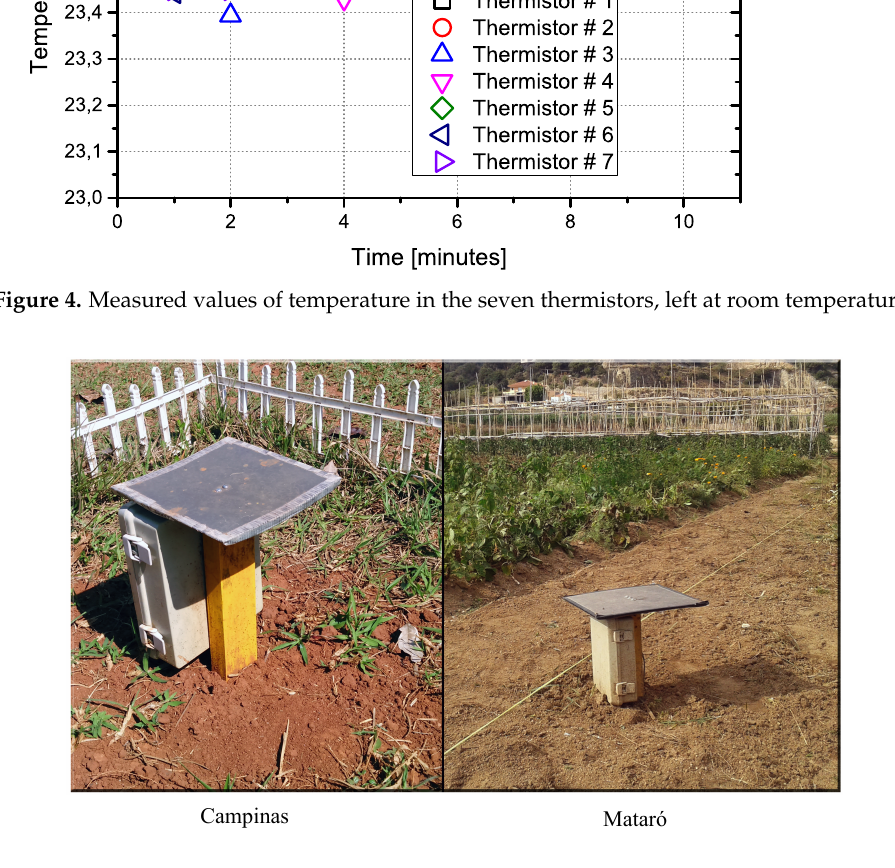
Figure 5. Photographs of the soil temperature profile measurement systems installed in Campinas and